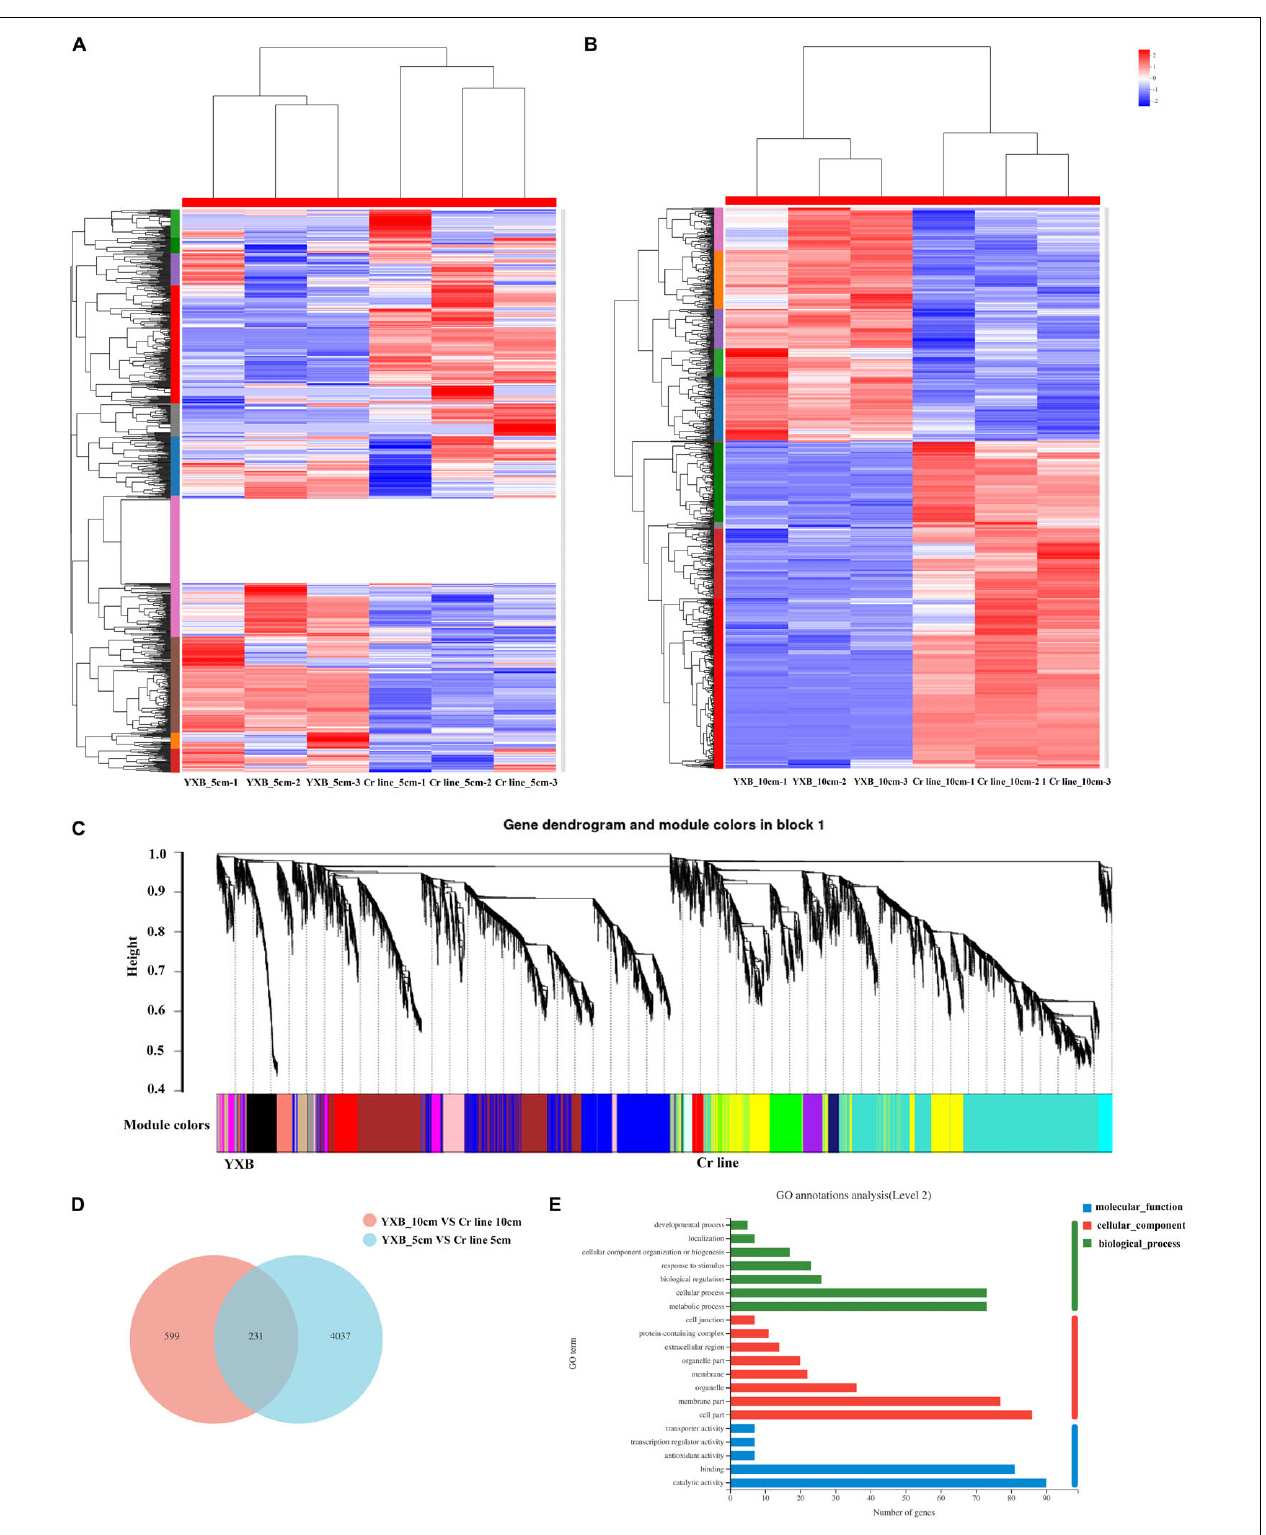
FIGURE 2 | OsMKK3 regulates genes in the early spike development stage. (A) Hierarchical clustering of the DEGs for the YXB and the Cr line in the spike development stage. (B) Weighted gene co-expression network analysis of DEGs identified from YXB and the Cr line in the spike development stage. (C) Common DEGs expressed in YXB_5cm_vs_Cr line_5cm and YXB_10cm_vs_Cr line_10cm. (D) GO enrichment analysis of common DEGs. (E) GO term of common DEGs.